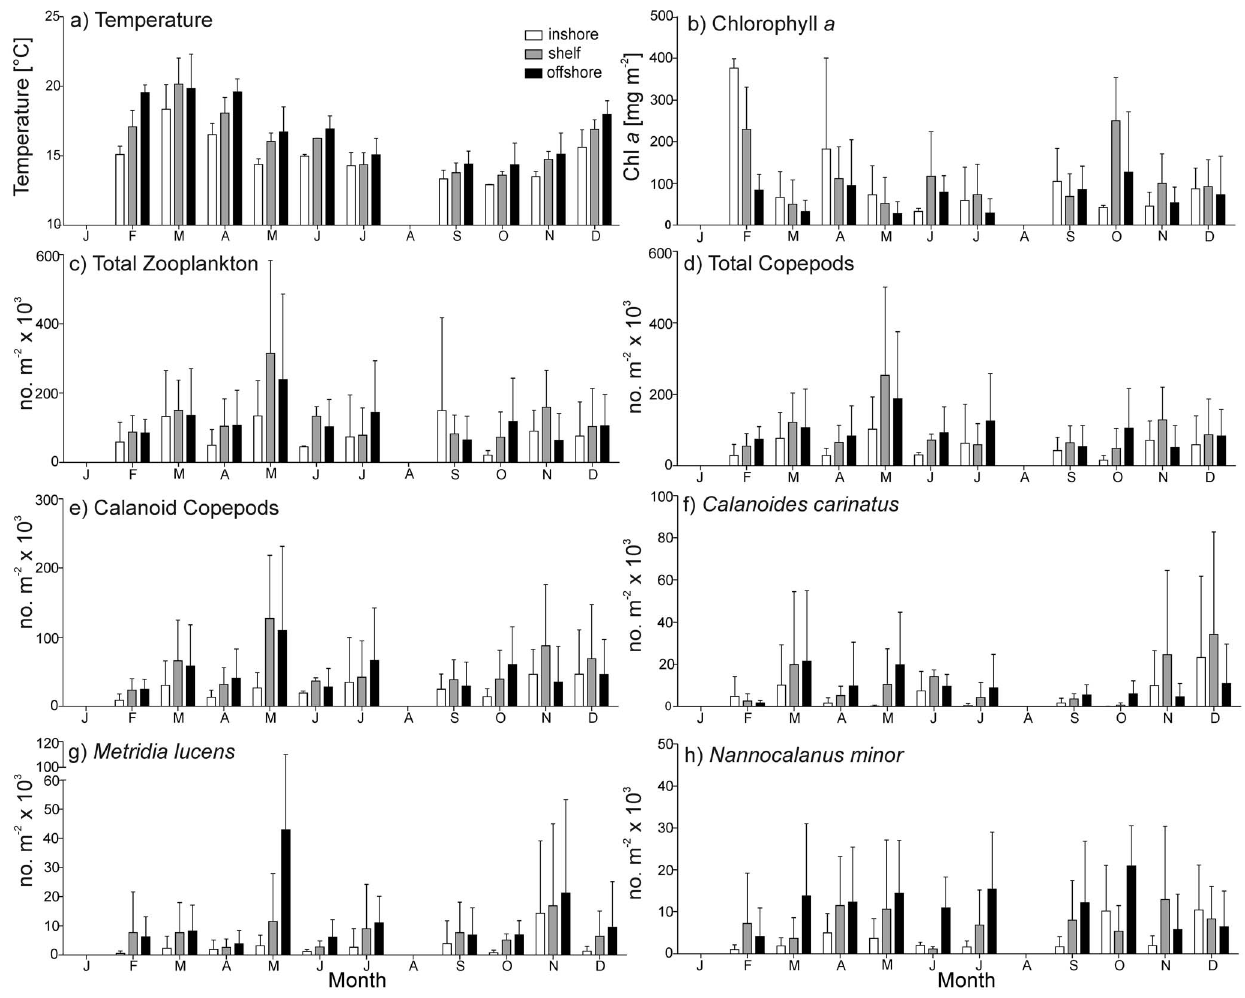
Figure 4. Monthly means ( ± SD) of a) temperature at 10 m, b) chlorophyll a , c) total zooplankton, d) total copepods, e) calanoid copepods, f) Calanoidescarinatus , g) Metridialucens and h) Nannocalanusminor . Note different